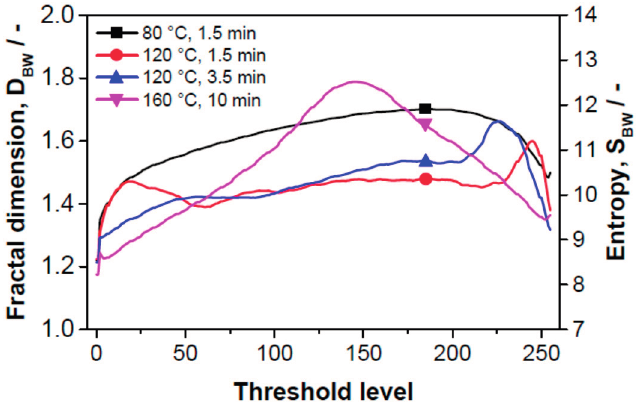
Figure 7. Dependence of the fractal dimension of the boundary of threshold images (resp. surface inhomogeneity expressed as topological entropy) on the threshold level of gray scale images.